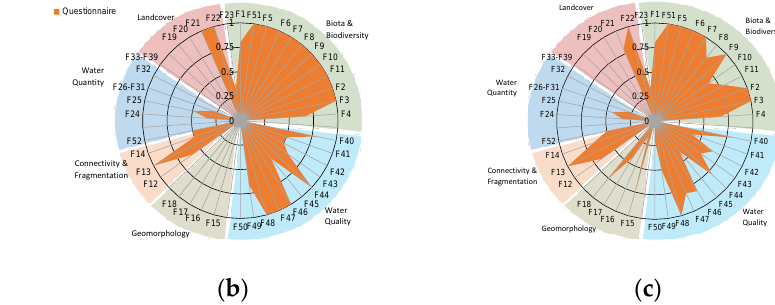
Figure 3. Spider diagram for GZBP ( a ) EEM result of new developed GZBP, ( b ) SBQ result of new developed GZBP, ( c ) and SBQ result of existing GZBP.